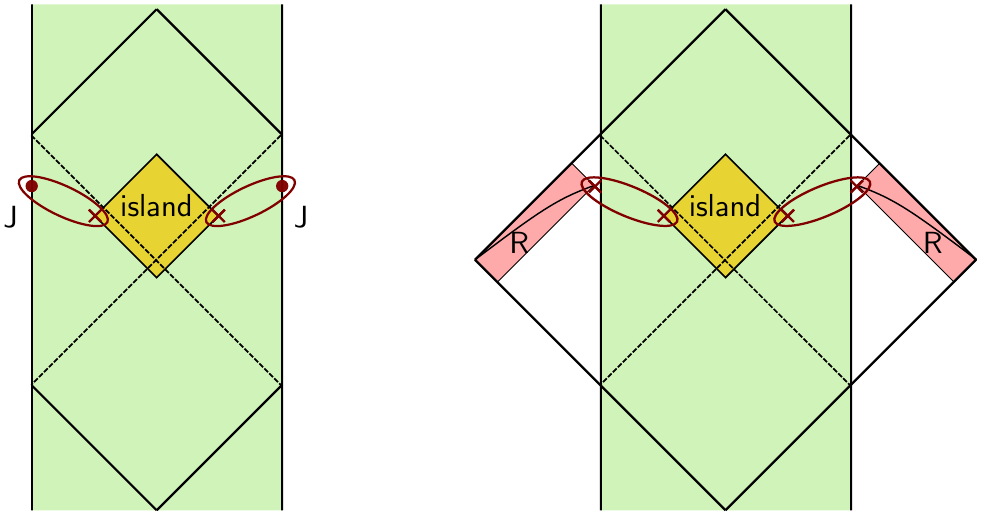
Figure 14 . Island of the journal versus the island in the East coast setup. At late times, the separation between the twists from the island are nearly null separated from the boundary twists. In this OPE limit, one can approximate the entropy as the sum of two semi-infinite intervals discussed in section